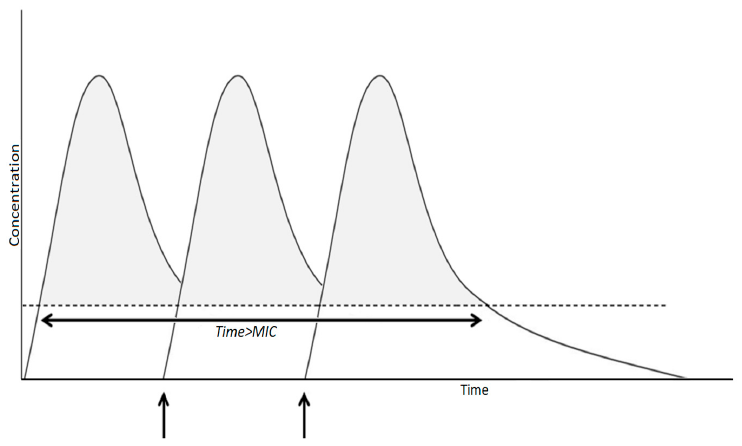
Figure 3. Time-dependent antimicrobial pharmacokinetic in intermittent administration. Antimicro- bial efficacy is determined by the time above MIC (T > MIC) of plasmatic unbound drug concentration. Arrows shows the time of administrations.